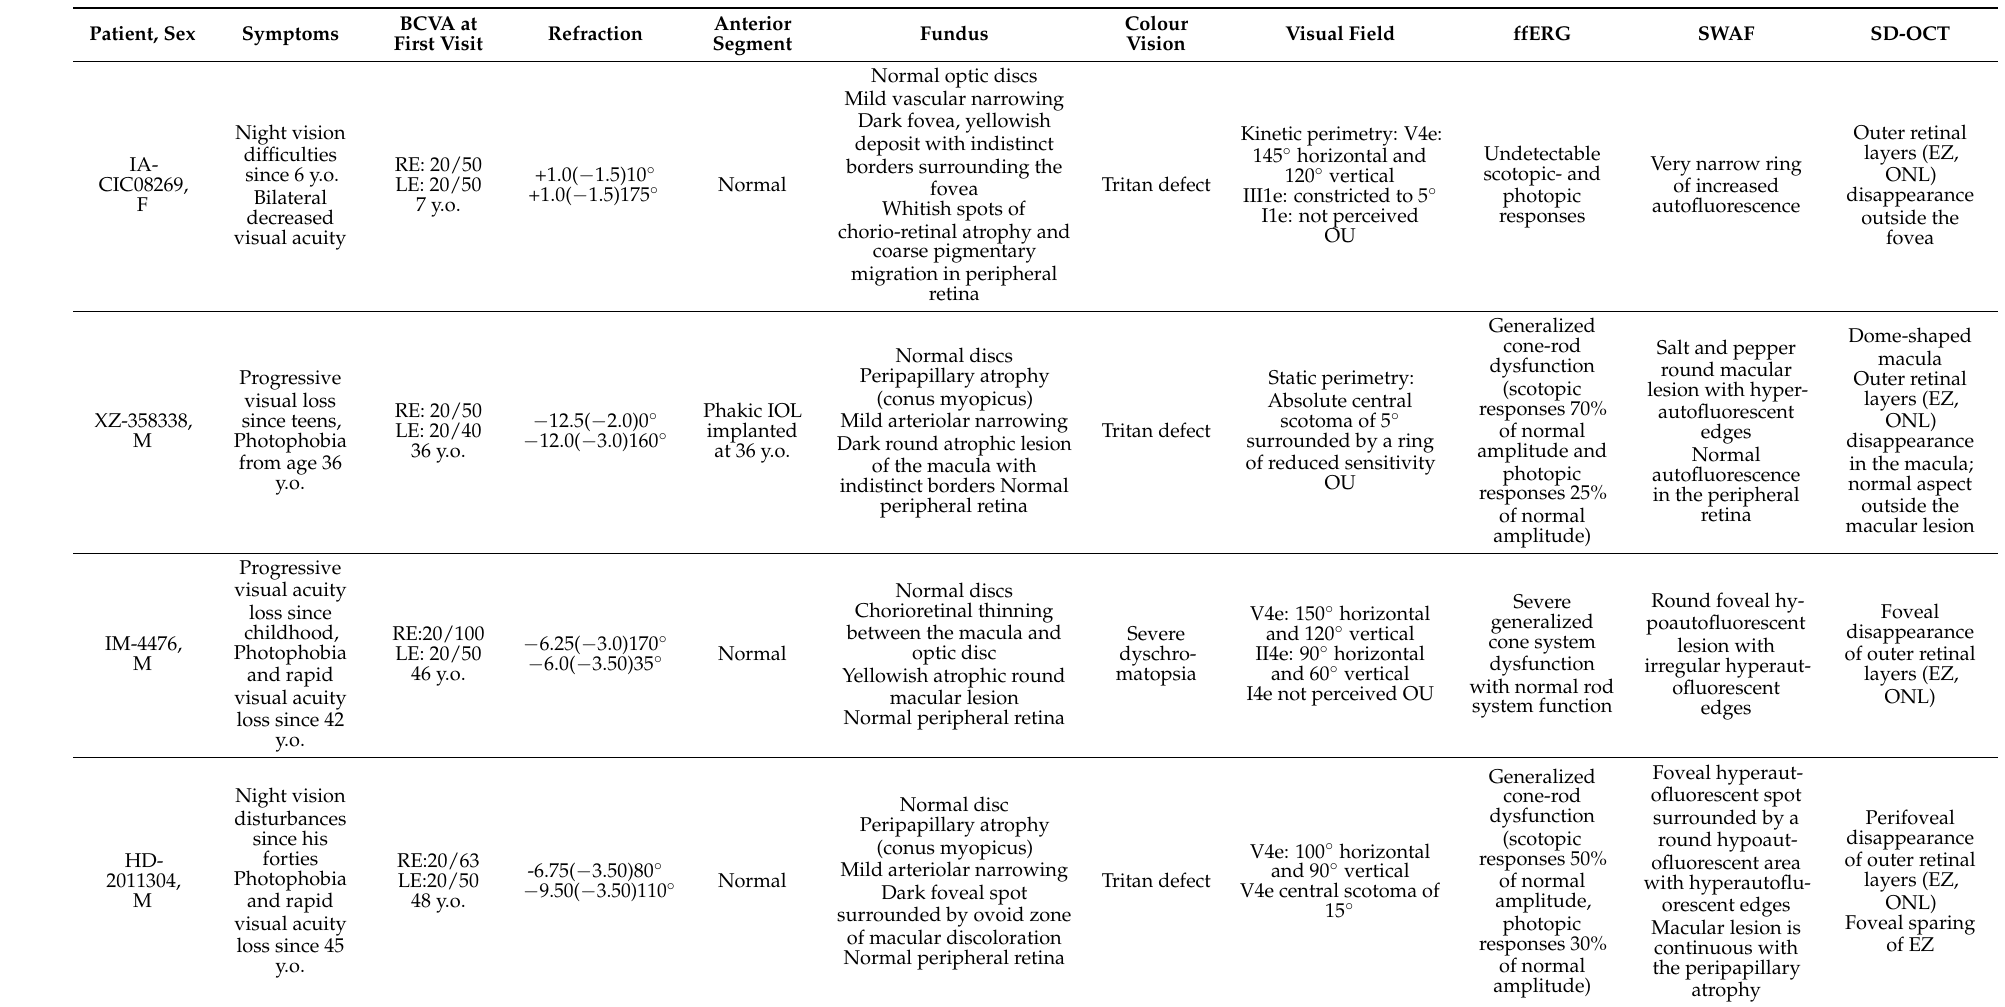
Table 1. Clinical characteristics of